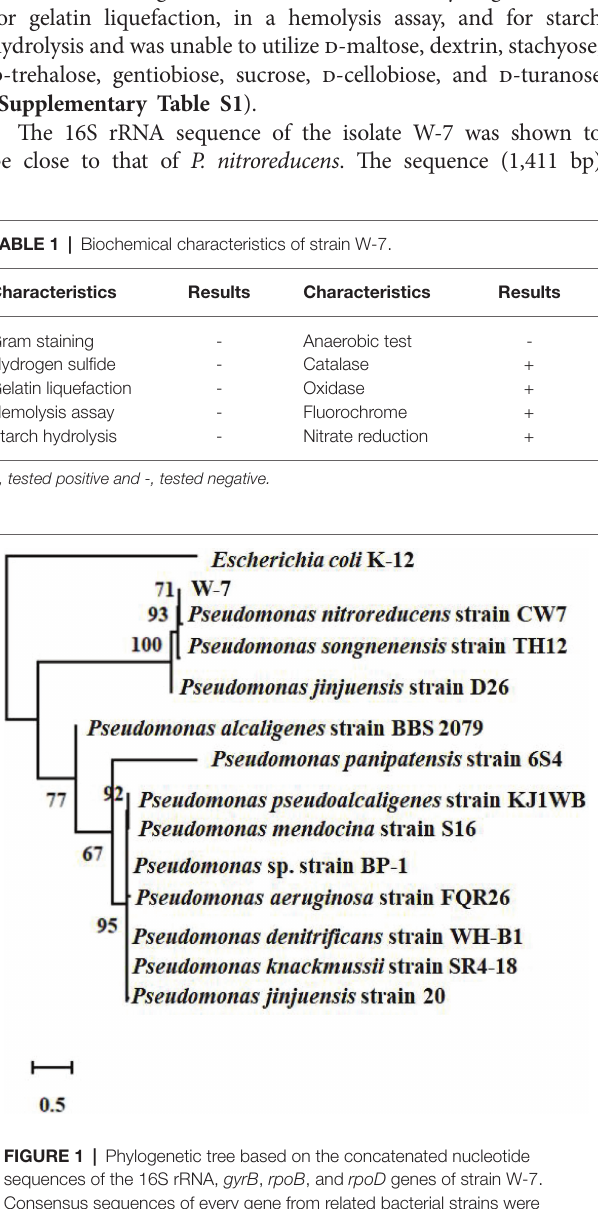
FIGURE 2 | Degradation of N -(3-oxododecanoyl)-L-homoserine lactone (OdDHL) during the growth of strain W-7. Symbols: black rotundity ● , OdDHL control; black square ■ , OdDHL degradation; black triangle ▲ , growth of strain W-7.